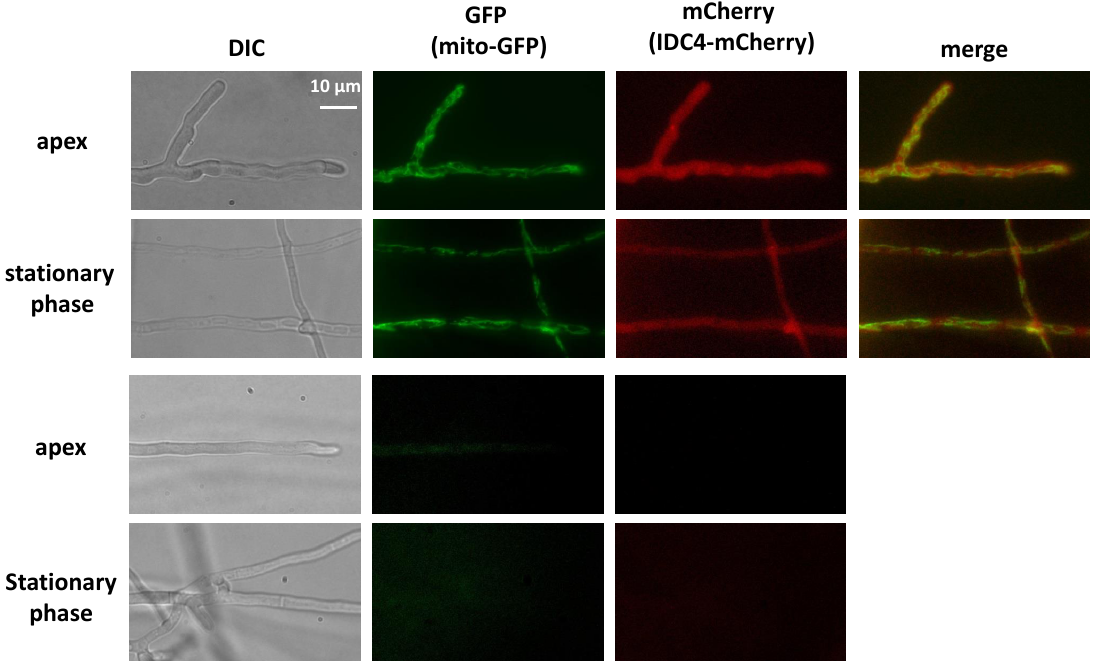
Figure 6. Cellular localization of IDC4. The two top rows are the strain carrying the mito-GFP and IDC4-mCherry transgenes. Red fluorescence in apical and stationary phase hyphae from 3-day-old hyphae carrying both transgenes was located in the cytosol, while the green fluorescence was detected in elongated mitochondria. The two bottom rows are from the wild type that does not carry transgenes; no fluorescence was detected in the wild